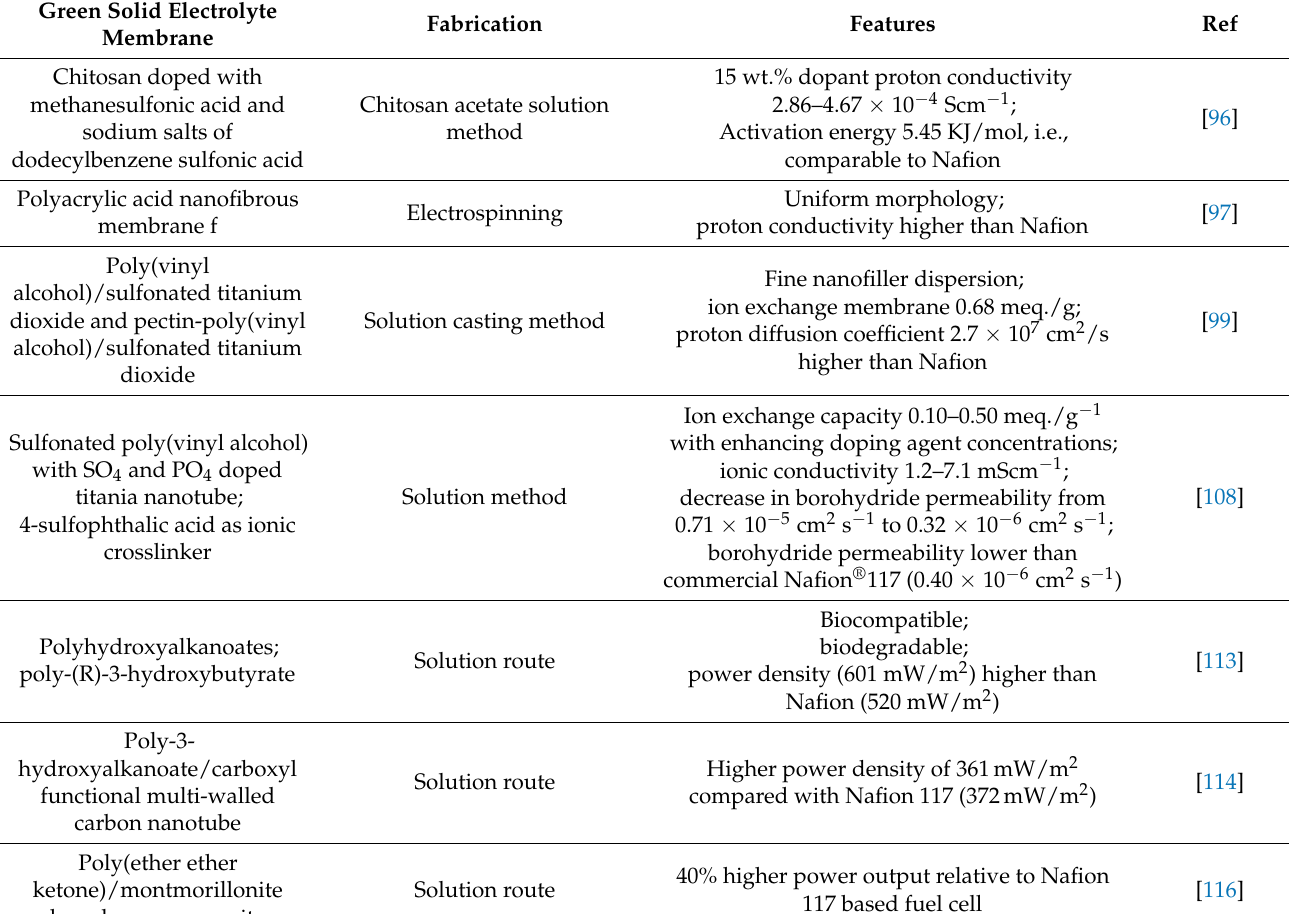
Table 3. Characteristics of green solid electrolyte